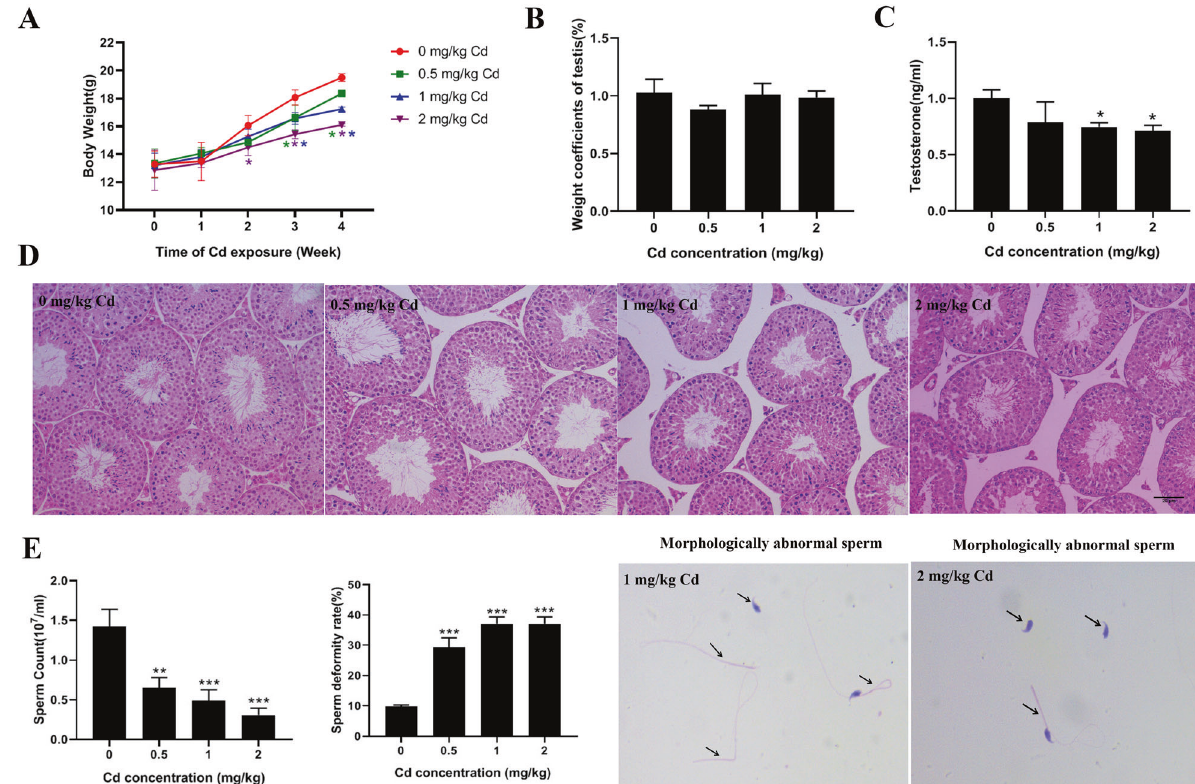
Fig. 1 The effect of cadmium exposure on testicular toxicity. A The body weight of mice was recorded every day during the exposure period and weekly body weight was shown ( n = 5 in each group). B Testis/body weight index of four groups. C Measurement of serum testosterone levels in four groups of mice. D Representative histology of the testis from each group, scale bar: 20 μ m. E The number of sperm from cauda epididymides and deformity rate were examined, and abnormal sperm morphology was shown. Arrows indicate morphologically abnormal sperm. (* P < 0.05, ** P < 0.01, *** P < 0.0001 vs.